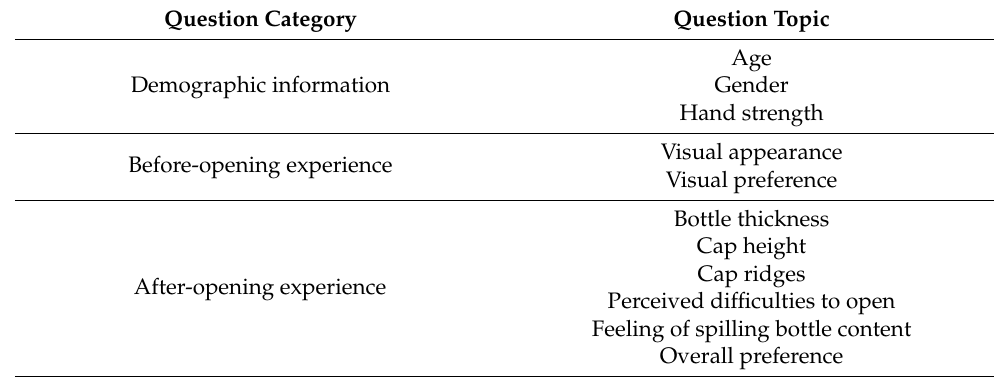
Table 1. Questionnaire structure to measure the ease of use of single-use plastic water bottles.